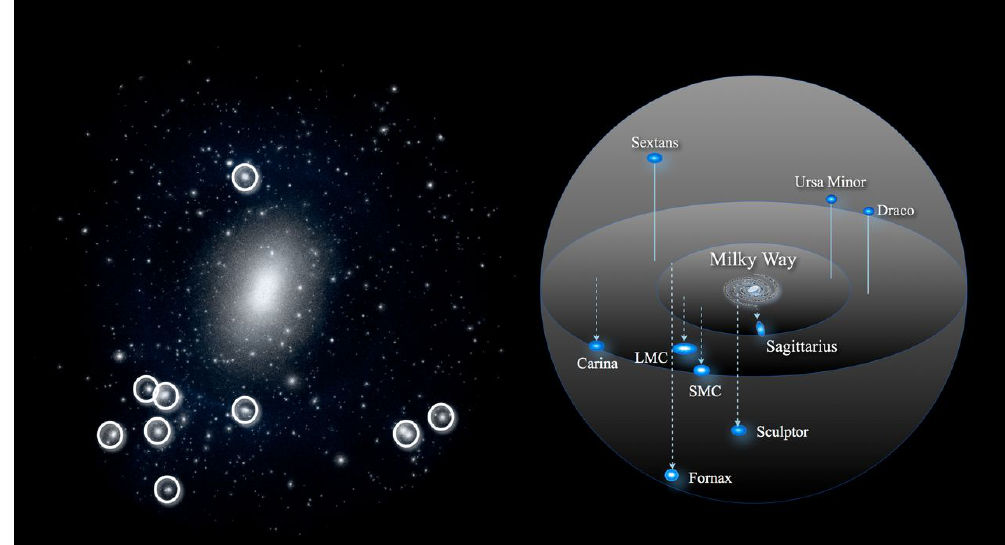
Figure 7. Left panel : Projected dark-matter distribution (600 kpc on a side) of a 10 12 M (cid:12) dark-matter halo from the ELVIS Λ CDM simulations [56]. The number of small subhalos strongly exceeds the number of known Milky Way satellites (missing satellites problem; Section 3.3). The circles highlight the nine most massive subhalos. Right panel : Spatial distribution of the closest nine of the 11 most luminous (classical) satellites of the Milky Way (the diameter of the outer sphere is 300 kpc). For these satellites, the central mass inferred from stellar kinematics is a factor of ∼ 5 lower than the mass predicted for the central regions of the subhalos highlighted in the left panel, preventing the association of the classical satellites to the most massive subhalos of the dark-matter halo of Milky Way-like galaxies (too-big-to-fail problem; Section 3.4). The figure is reproduced from